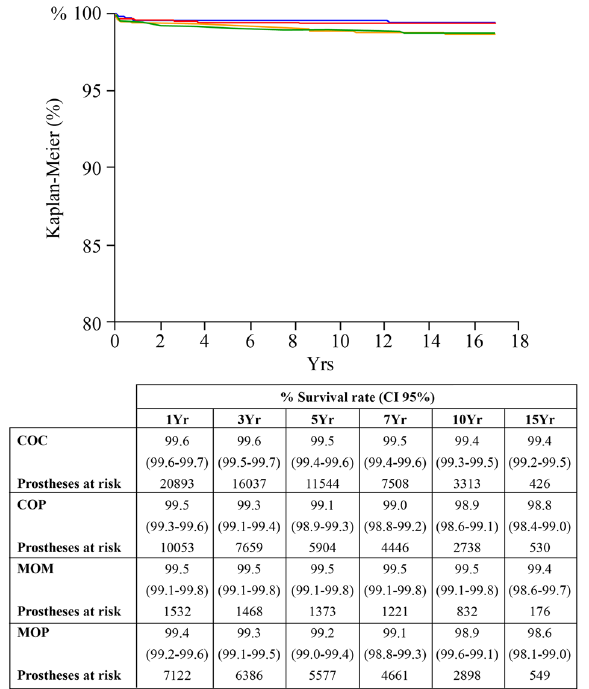
Fig. 1 The Kaplan – Meier curves (endpoint: revisions due to recurrent dislocations and primary instability) showed that COC implants were signi fi cantly less prone to dislocations than COP THAs (unadjusted rates). COC: red line; COP: green line; MOM: blue line; MOP: orange hard-on-soft articulations (COP and MOP) (unadjusted rates; p < 0.05) (Fig. 1).